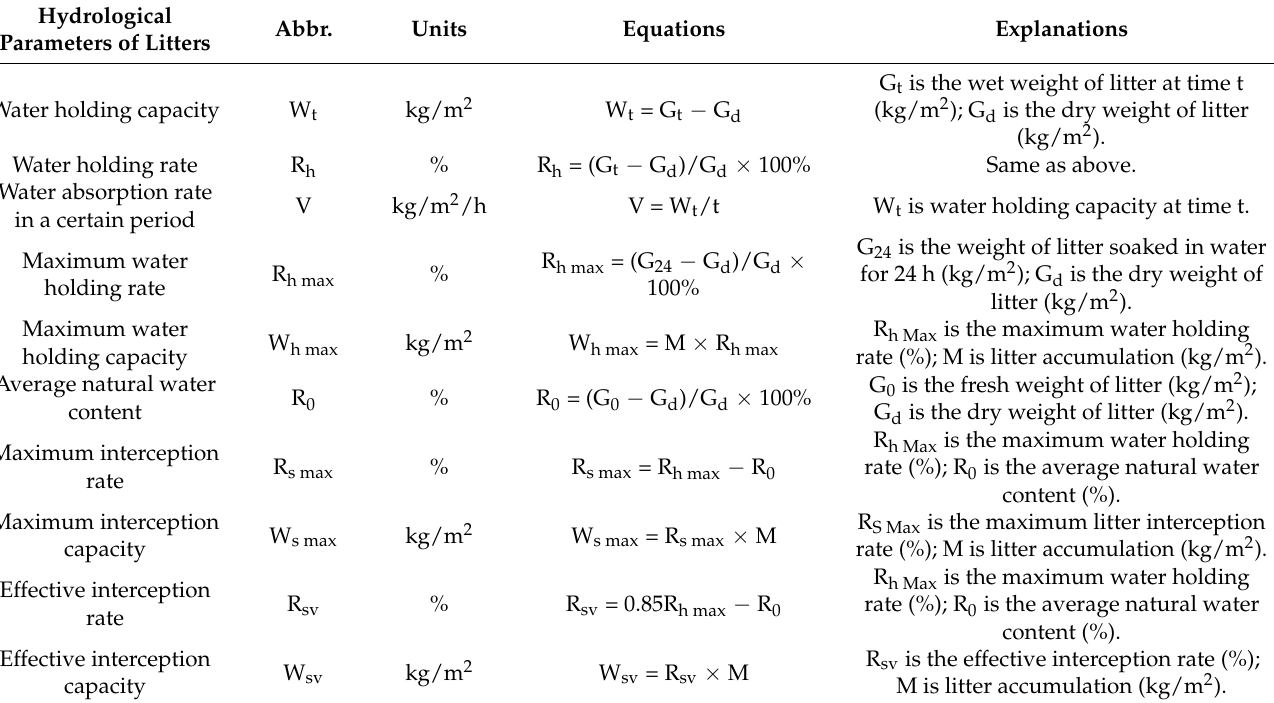
Table 2. The hydrological parameters of